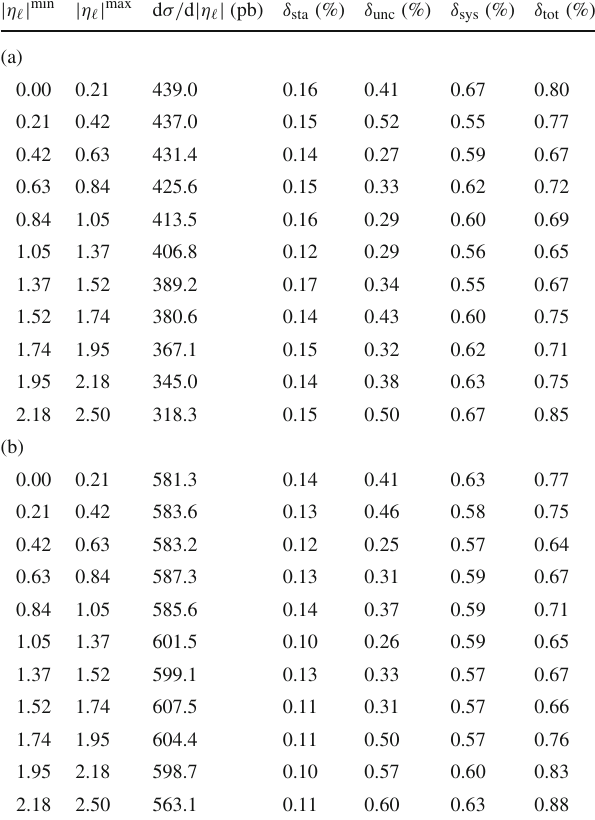
Table 29 Differential cross section for the Z /γ ∗ → μ + μ − process in the region 46 < m (cid:3)(cid:3) < 66 GeV (a) and 116 < m (cid:3)(cid:3) < 150 GeV (b), extrapolatedtothecommonfiducialregion.Therelativestatistical( δ sta ), uncorrelated systematic ( δ unc ), correlated systematic ( δ sys ), and total ( δ tot ) uncertainties are given in percent. The overall 1 . 8% luminosity uncertainty is not